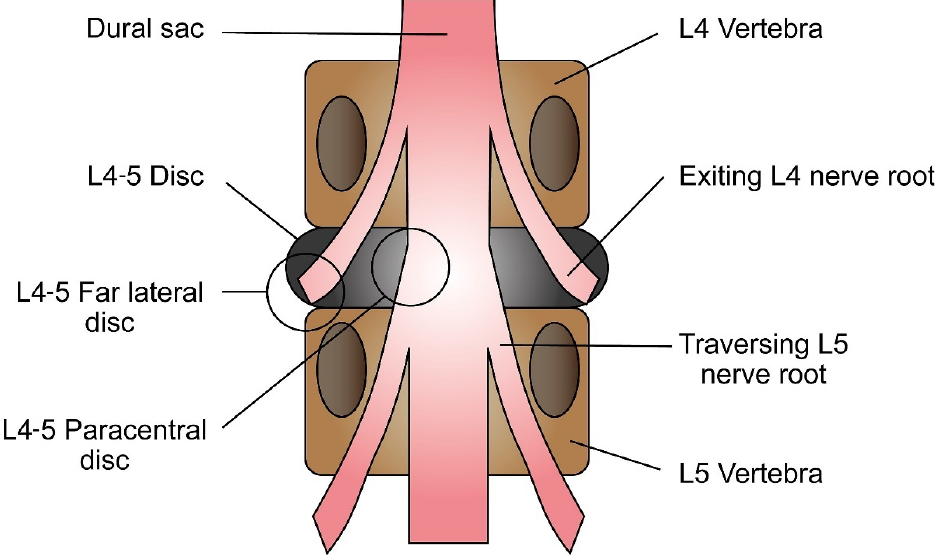
Figure 2. Representation of L4-L5 disc level showing how the anatomy of the disc herniation would affect the exiting or traversing nerve roots.